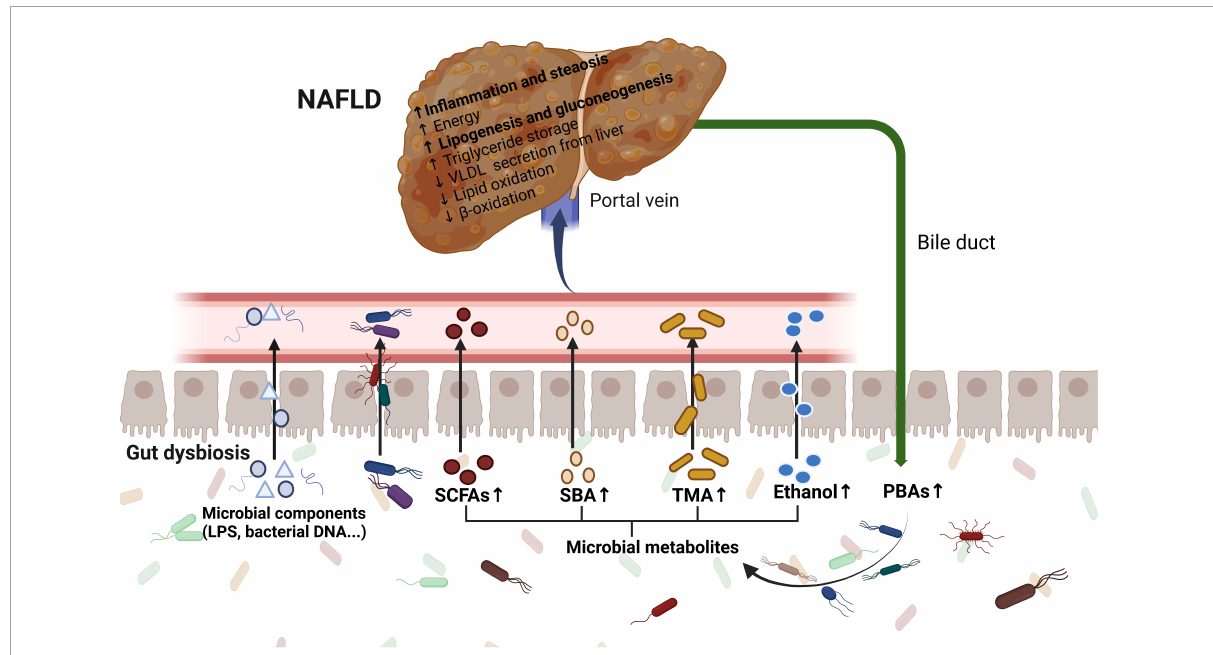
FIGURE2 The role of the gut microbiome in the pathogenesis of NAFLD. Gut dysbiosis leads to increased intestinal permeability, increased dietary energy harvest, altered microbial metabolites including SCFAs, BAs, TMA, and ethanol, and increased microbial endotoxins. The communication via systemic mediators is not shown. LPS, lipopolysaccharide; SCFAs, short-chain fatty acids; SBAs, secondary bile acids; PBAs, primary bile acids; TMA, trimethylamine; VLDL, very low-density lipoprotein.